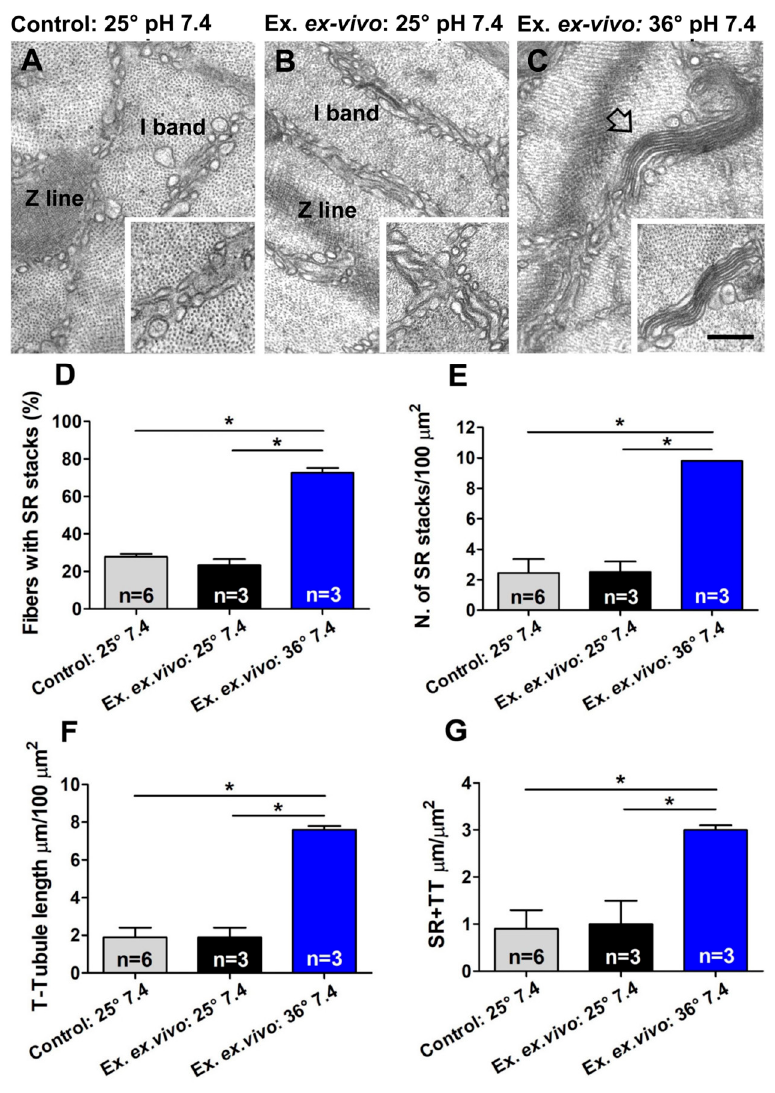
Figure 4. Electron-micrographs and quantitative analysis of assembly of CEUs at 25 vs. 36 ◦ C (pH 7.4) . ( A – C ) EM images of fibers in isolated EDL muscles that: (i) have rested at 25 ◦ C and pH 7.4 for 45 min (panel ( A )); (ii) have been subjected to the ex vivo exercise protocol performed at 25 ◦ C and pH 7.4 (panel ( B )); and (iii) have been subjected to the ex vivo exercise protocol performed at 36 ◦ C and pH 7.4 (panel ( C )). The insets in panels ( A , B ) show SR appearance at the I band; the empty arrow and the inset in panel ( C ) show the remodeling of SR in stacks. ( D , E ) Percentage of fibers containing SR stacks and number of SR stacks/100 µm 2 of section. ( F , G ) Extension of TTs at the I band in 100 µm 2 of section and analysis of SR-TT contact length. Data are shown as mean ± SEM (* p < 0.05). n = number of EDL analyzed. Scale bar: ( A – C ) = 0.1 µm; insets = 0.2 µm.